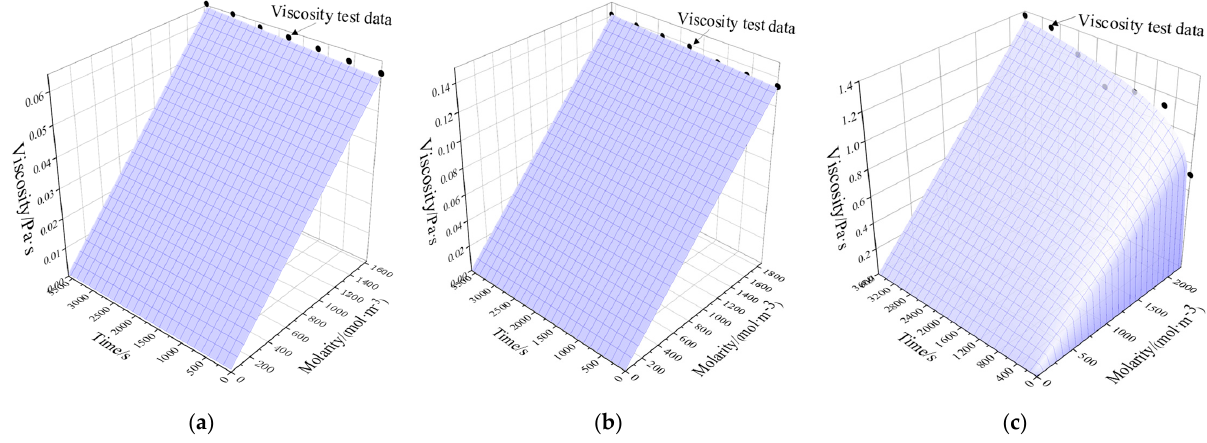
Figure 1. The three-dimension curved surface of linear interpolation of cement paste viscosity with respect to time and concentration for three water–cement ratios; ( a ) w:c = 1.0; ( b ) w:c = 0.8; ( c ) w:c = 0.6.